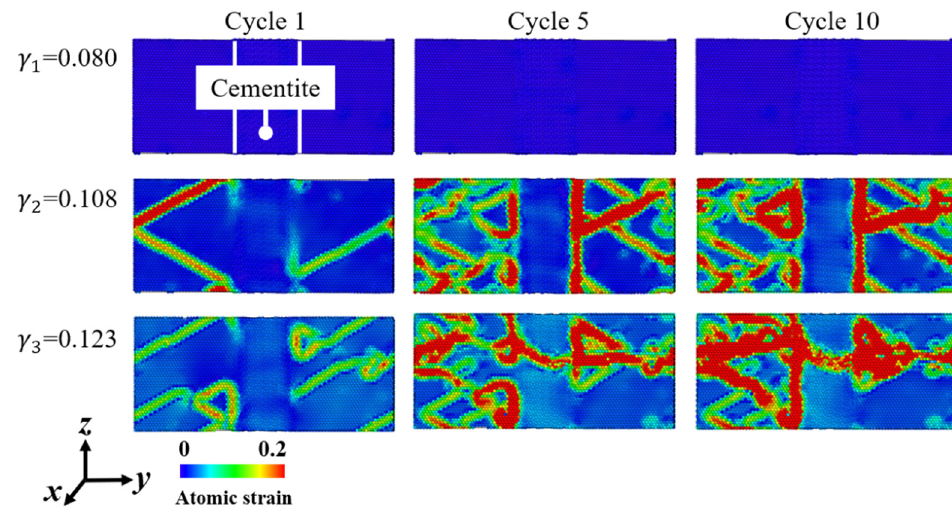
Figure 12. Evolution of high-strain atoms in the model under different shear strain levels when shear deformation is along x -axis. Display range of atomic strain is 0–0.2.